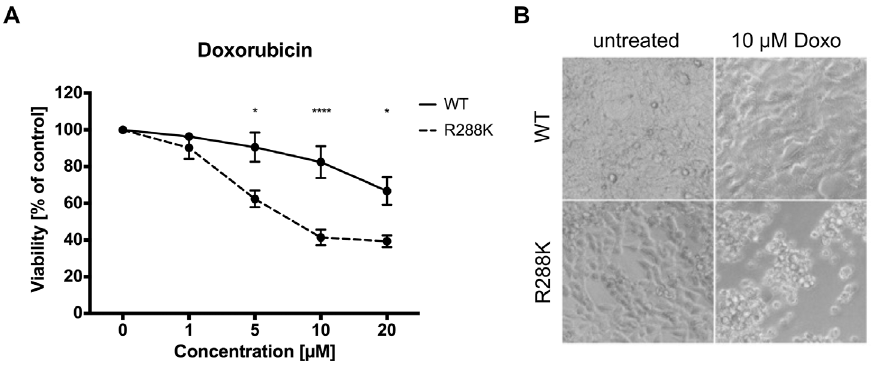
Figure 2. Induction of cellular multidrug resistance in vitro by ABCA3. (A) Effects of soluble doxorubicin on viability of HEK293 cells stably expressing ABCA3-WT or ABCA3-R288K protein. Different concentrations of doxorubicin were used and viability was measured with XTT assay. Values are displayed as means ± SEM of HEK293 cells stably expressing either ABCA3 wild-type protein (solid line) or R288K mutated ABCA3 protein (dashed line). * P < 0.05; **** P < 0.0001. (B) Light microscopy of HEK293 cells stably expressing ABCA3-WT and ABCA3-R288K protein respectively. Additionally cells were treated with 10 μ mol/L doxorubicin for 3 h and displayed after 24 h of growth in RPMI medium supplemented with 10% FCS under normal